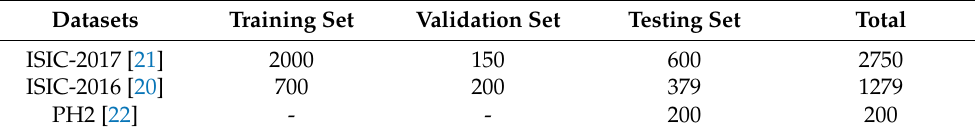
Table 1. Our partition of experiment